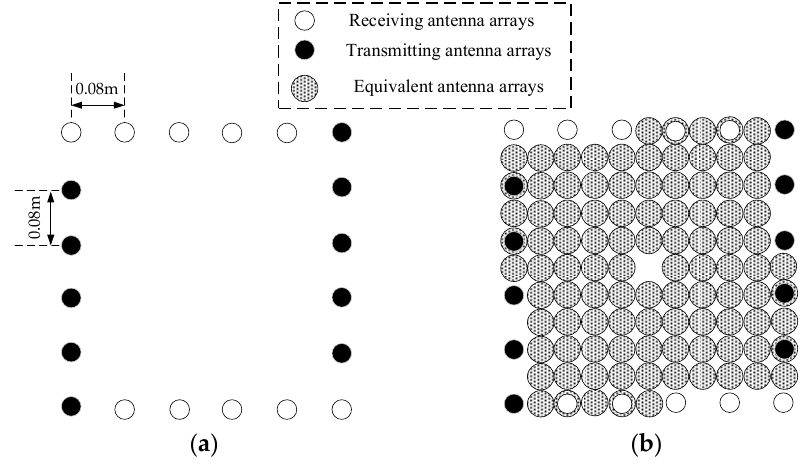
Figure 4. ( a ) Antenna array; ( b ) Virtual array elements. Table 2. Parameters of simulation